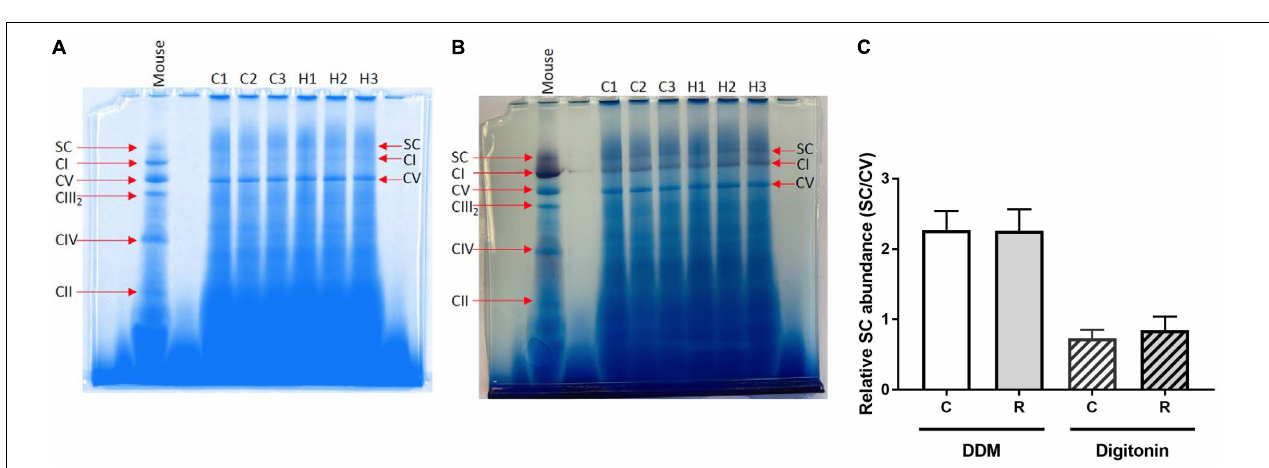
FIGURE 4 | Effects of hypoxia and reoxygenation (H/R) on oxygen consumption rates ( ˙MO 2 ) and ROS efflux of isolated digestive gland mitochondria of M. edulis . (A) oxygen consumption rates during LEAK I+II (PLI+II) and OXPHOS respiration, (B) ROS efflux during LEAK I+II (PLI+II) and OXPHOS respiration, (C) Electron leak rate during LEAK I+II (PLI+II) and OXPHOS respiration. All activities were assessed at 25 ◦ C. The percentage change following H/R stress was calculated by standardizing the control values at the respective temperatures to 100%. Significant differences in each mitochondrial trait between normoxia (C) and reoxygenation (R) are denoted by asterisks (** P < 0.01).